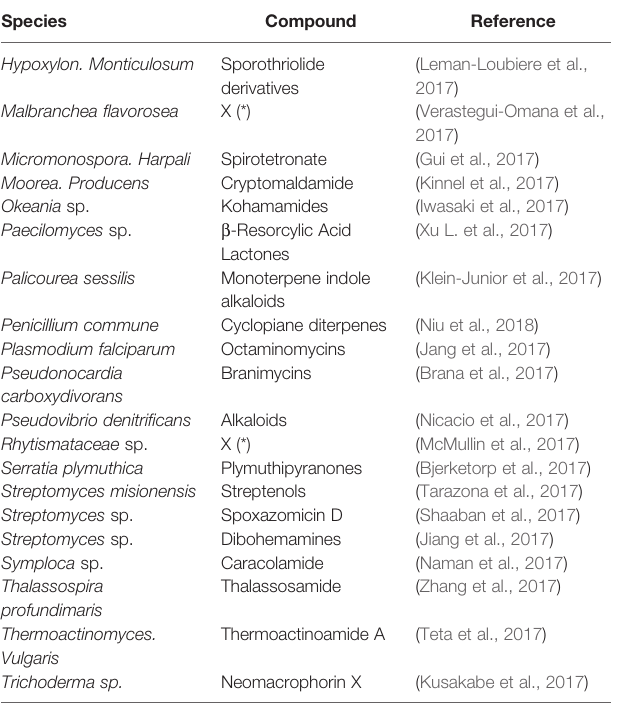
TABLE 2 | Some examples of compounds isolated from